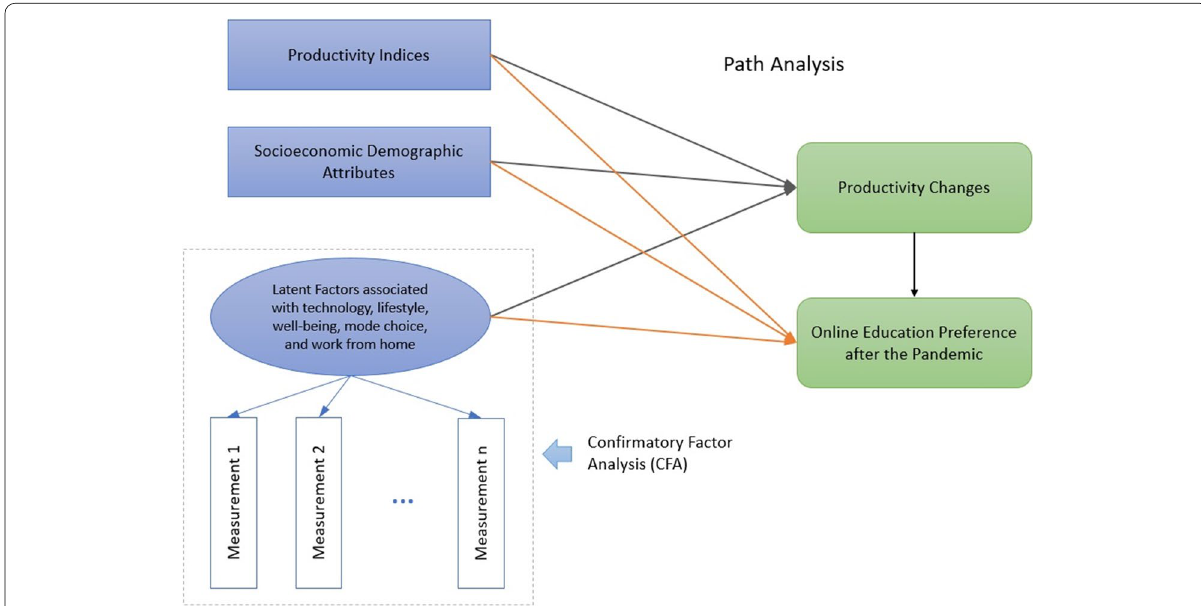
Fig. 8 Structural equation model (SEM) path